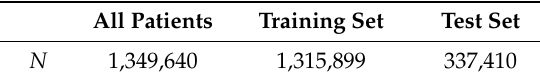
Table 1. Distribution of training and test